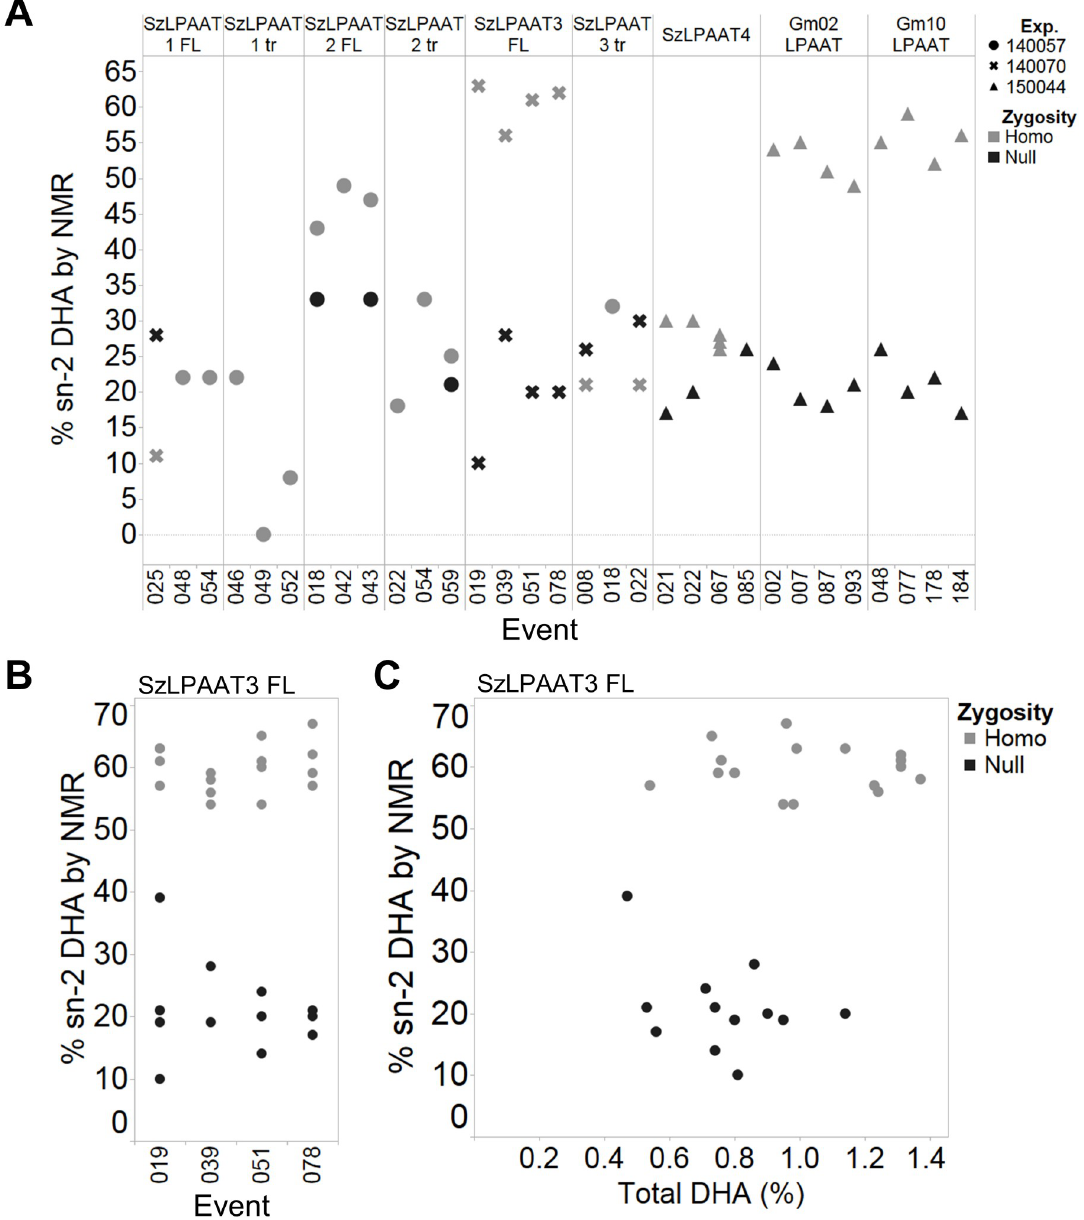
Fig 5. Positional analysis of DHA in T 3 seed oil determined by band-selective HSQC NMR. (A) Positional analysis of DHA from T 3 homozygous and null lines. Three to four independent events from each construct were analyzed. Shapes differentiate the planting batch experiment. (B) Positional analysis of DHA in additional T 3 SzLPAAT3 FL lines. Two high DHA-producing lines, a medium DHA- producing line, and a low DHA-producing line were selected from the homozygous and null lines for positional analysis. (C) Comparison of total DHA determined by GC-FID and relative percent sn -2 DHA TAG determined by band-selective HSQC NMR for T 3 SzLPAAT3 FL